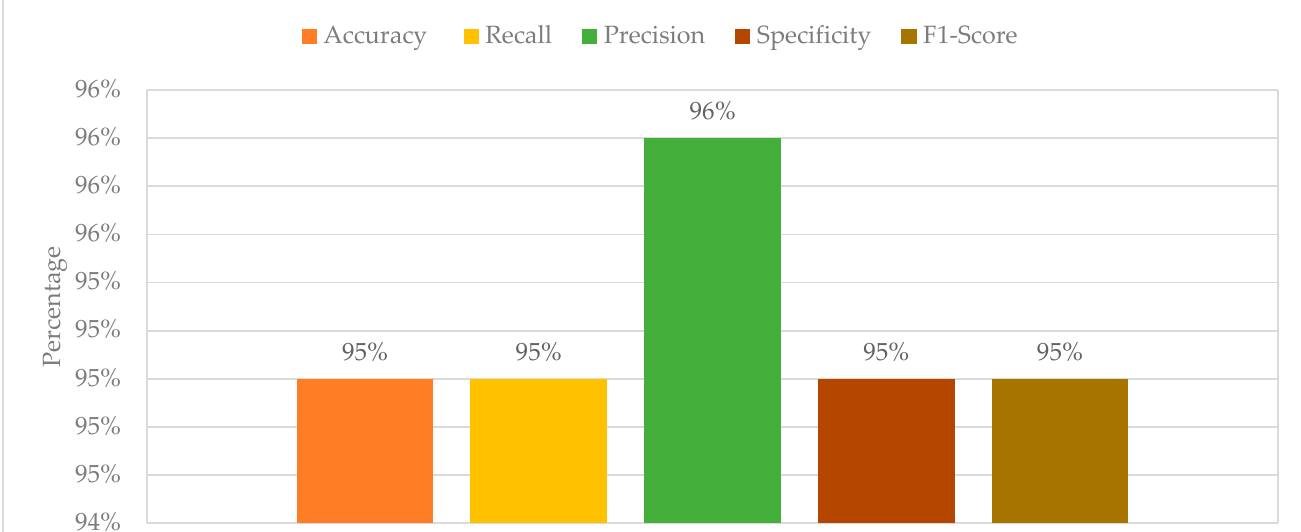
Figure 14. Evaluation metrics for the proposed model.